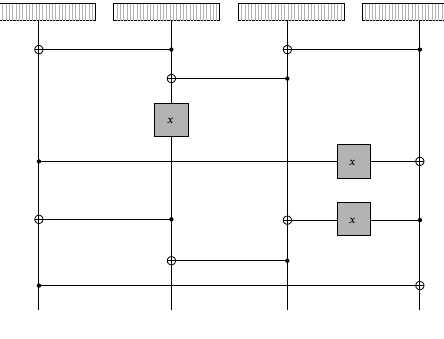
Figure 10: Shadow-512 v2 diffusion